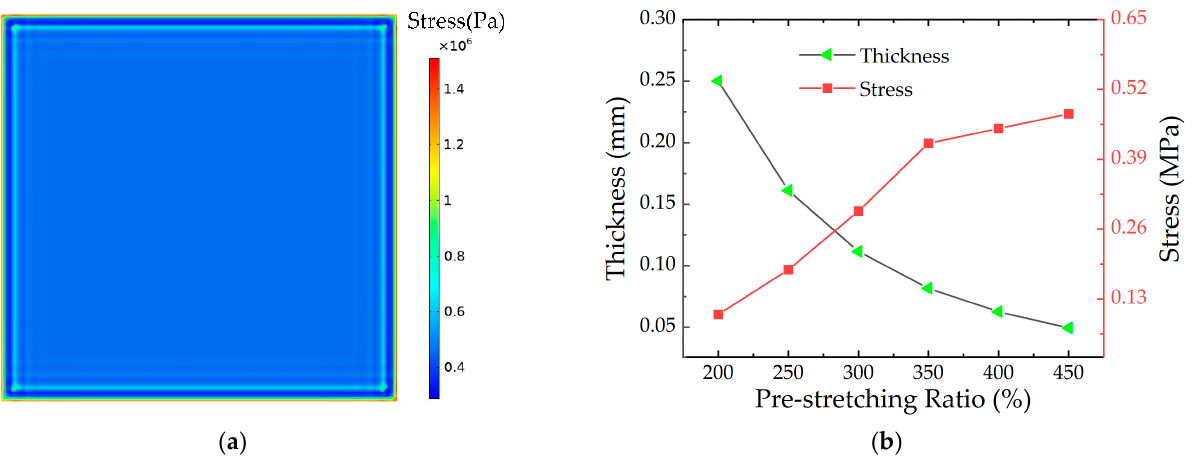
Figure 3. Stress cloud and data diagram. ( a ) Stress cloud of the DE membrane; ( b ) Thickness and center stress data of the DE membrane.